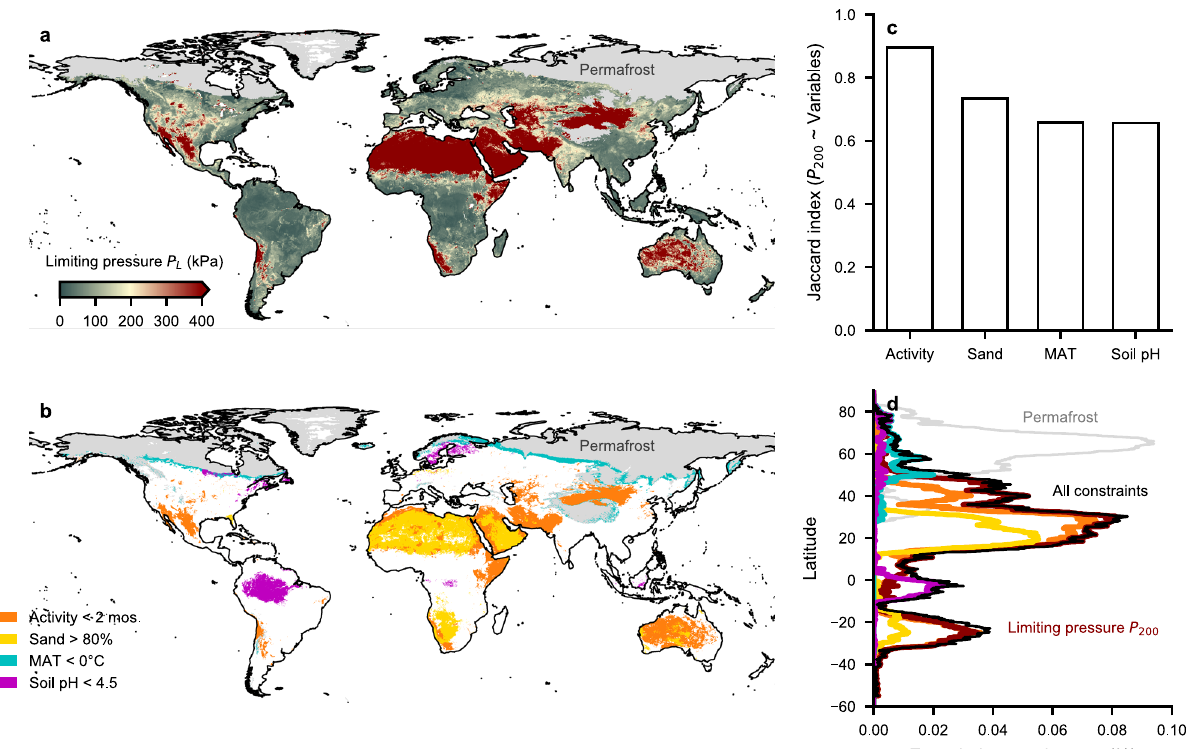
Fig. 2 Global map of earthworm hospitable zones. a Green regions indicate that annual average pressures required for cavity expansion are below the earthworm ’ s hydrostatic pressure limit (200 kPa). Pressures are truncated to values below 400kPa for visualization (dark red) and permafrost regions were removed (gray). b Other factors that may impede earthworm activity. Cyan regions indicate the sub-zero mean annual temperature (MAT), magenta regions mark soil pH < 4.5, yellow regions indicate coarse soil texture (sand content > 80%), and orange regions indicate that there are fewer than two consecutive months during which the soil mechanical properties permit cavity expansion. Regions of different limiting factors may overlap and were ordered for visibility. c Overlap in the area (Jaccard index) that is considered hospitable based on pressure below 200 kPa (P 200 ) compared with other variables. d Latitudinal distribution of terrestrial area that is excluded by considering each variable independently (colored lines) and the fully constrained habitat area